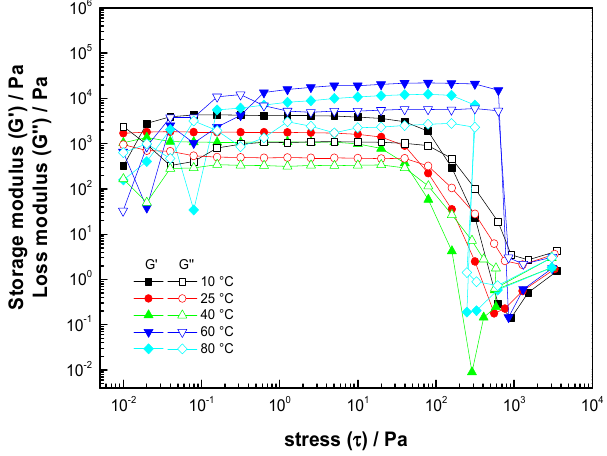
Figure 3. Stress sweep of hydrocolloids from Pereskia bleo leaves.